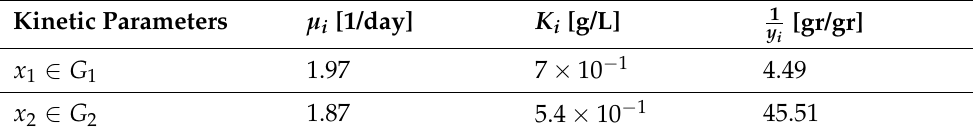
Table 4. A set of kinetic parameters of model (25).